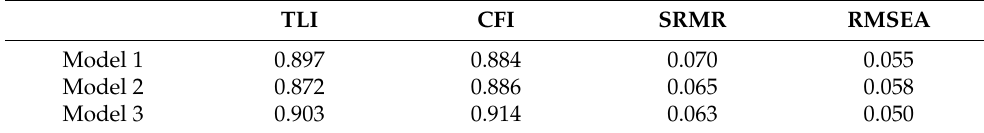
Figure 2. Model 2 with standardized factor loadings on control (C), ownership and origin (O 2 ), reach (R), endurance (E), transcendence (T), and adversity quotient (AQ) ( n = 242). Table 3. CFA goodness-of-fit indices for the models on Sample 2 ( n = 242).